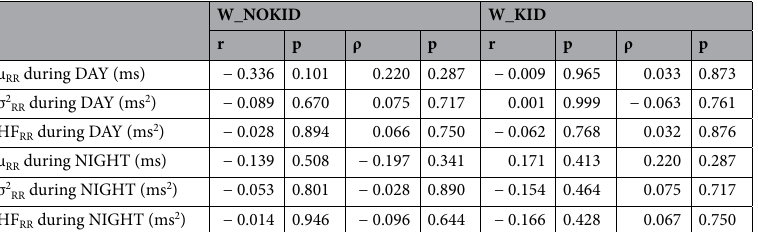
Table 2. Results of the correlation between heart rate variability indices and VAS scale of perceived stress. W_ NO KID, women without preschoolers; W_KID, women with preschoolers; RR, RR interval; μ RR , mean of RR; σ 2 RR , RR variance; HF RR , absolute power in high frequency band of the RR; DAY, daytime; NIGHT, nighttime; r, Pearson product moment correlation coefficient; ρ, Spearman rank correlation coefficient; p, type I error probability. Data are presented as mean ± standard deviation.